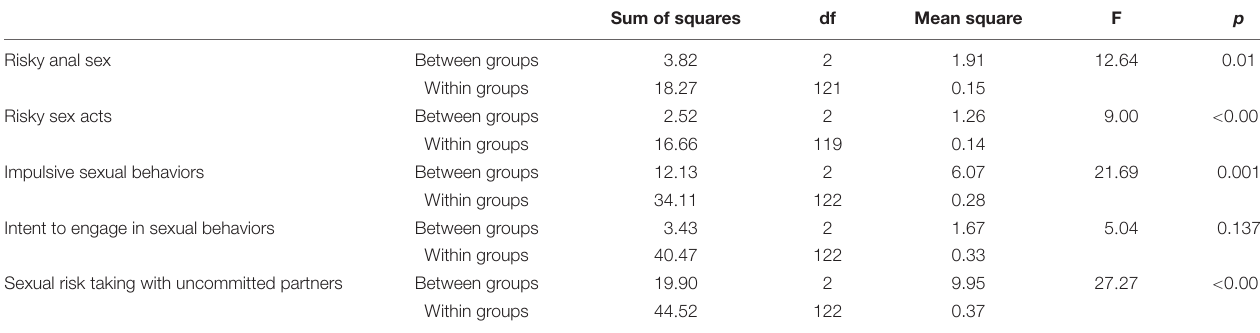
TABLE 2 | ANOVAs with the three profiles as independent variables and the five SRS scales as dependent variables. Sum of squares df Mean square F p Risky anal sex Between groups 3 .